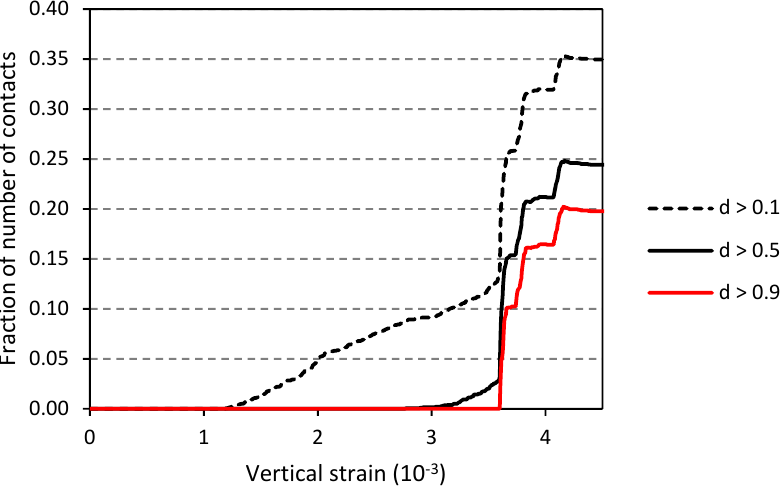
Figure 11 shows the number of contacts with damage greater than or equal to 0.1, 0.5 and